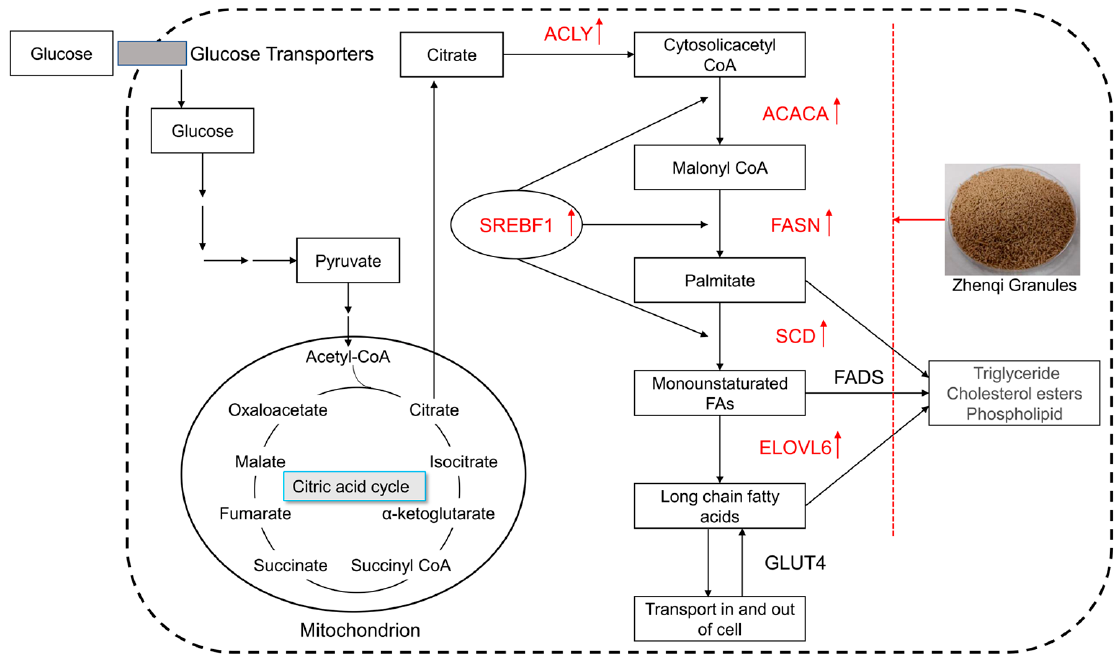
Figure 8. The process of de novo lipogenesis. Note: SREBF1, sterol regulatory element binding transcription factor 1; ACLY, ATP citrate lyase; ACACA, acetyl-CoA carboxylase alpha; FASN, fatty acid synthase; SCD, stearoyl-CoA desaturase; ELOVL6, ELOVL fatty acid elongase 6; FADS, fatty acid desaturase; GLUT4, glucose transporter 4.